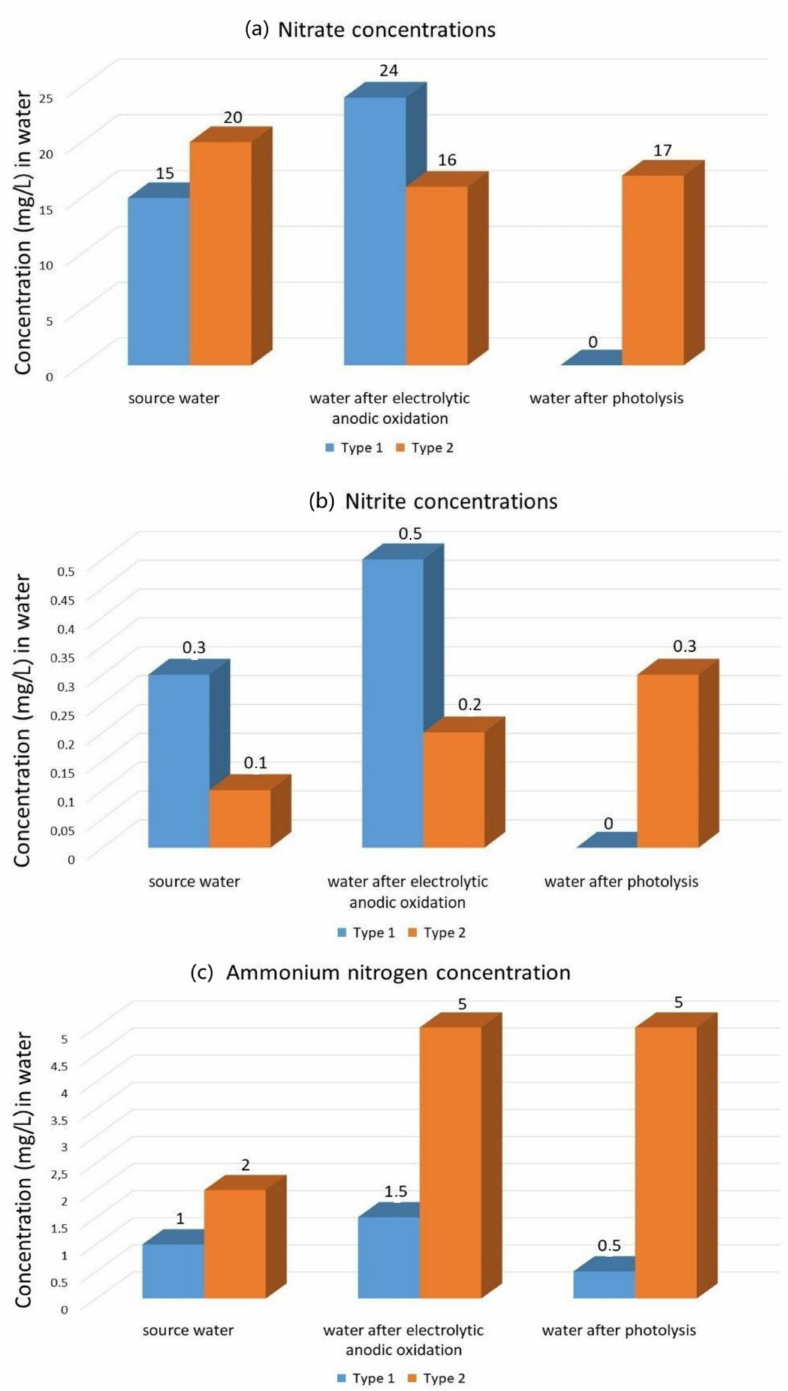
Figure 5. The results of experimental studies on the purification of wastewater from nitrogen compounds from CLWSI using